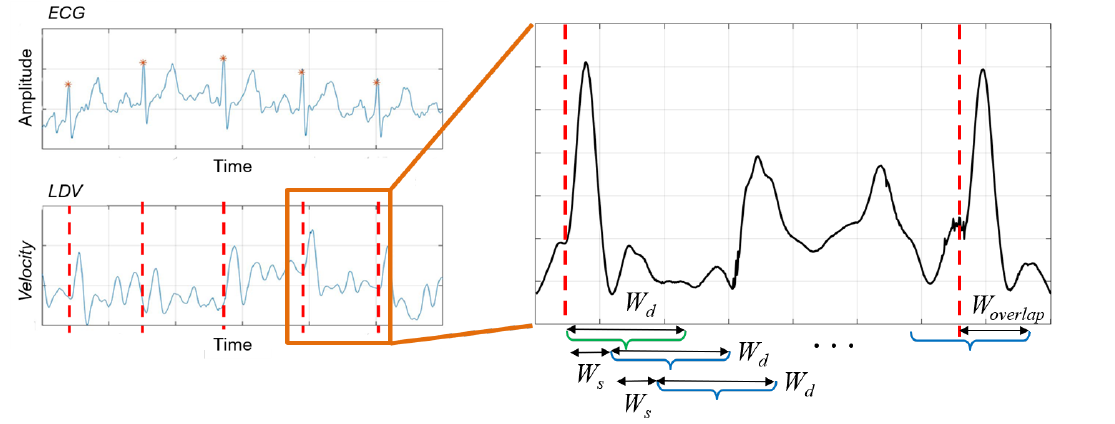
Figure 3. Sliding-window algorithm used to extract LDV signal windows. W d window size, W s =shift length, W overlap = overlap with a new beat. The green and blue windows denote beat and no-beat samples, respectively. (The LDV signal was smoothed for visualization purposes